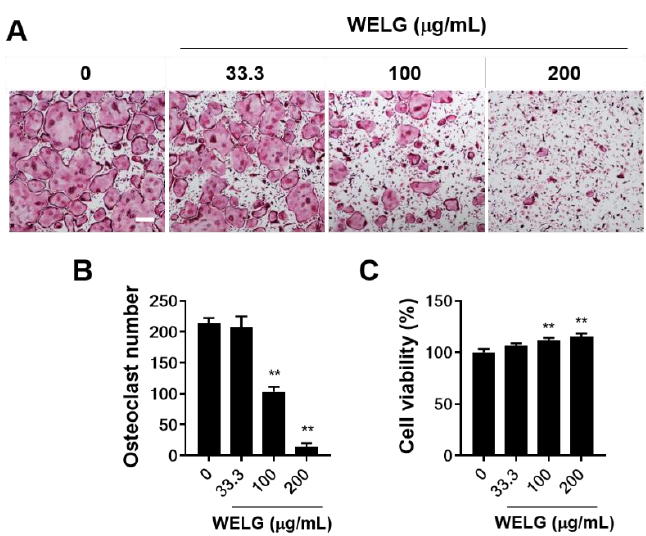
Figure 2. Suppression effect of WELG on RANKL-stimulated osteoclastogenesis. BMMs were treated with or without WELG in the presence of M-CSF (60 ng/mL) and RANKL (50 ng/mL) for 4 days. ( A ) TRAP-sta ining images of the cultures (scale bar, 100 μm). ( B ) The number of osteoclasts generated in the cultures. ( C ) Cell viability of BMMs after 24 h of treatment with WELG. ** p < 0.01 versus vehicle.